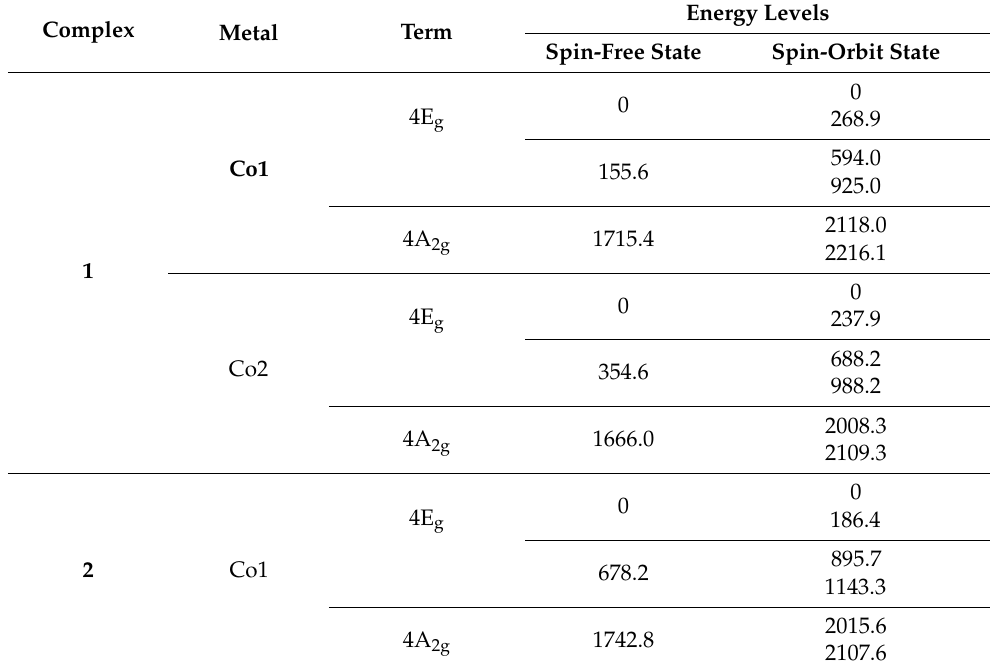
Table 1. SA-CASSCF-calculated spin-free and spin-orbit state energies (cm − 1 ) for 1 and 2 . Complex Metal Term